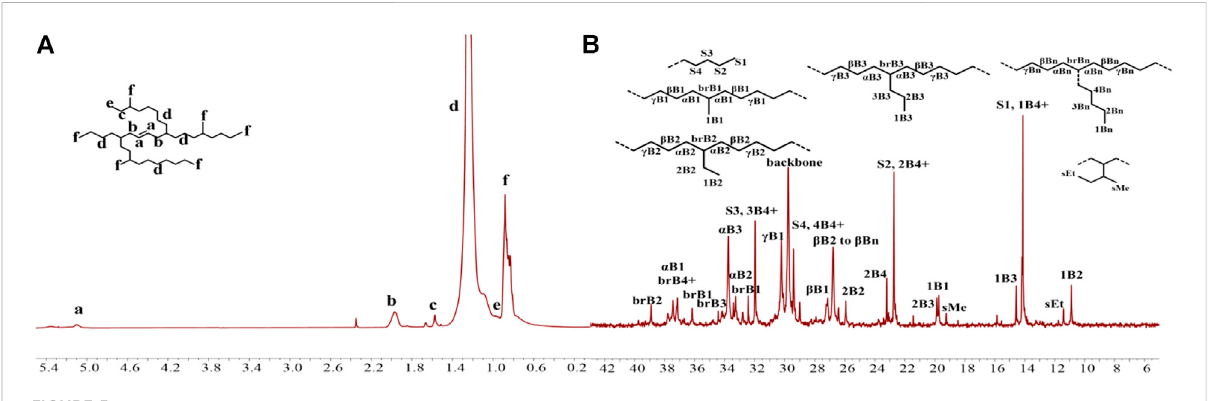
FIGURE 5 The 1 H (A) and 13 C (B) NMR spectral analyses of a hyperbranched ethylene oligomer obtained with Pd1 at 30 ° C. Assignments are numbered based on ref. Cotts et al., 2000; Randall, 1989; Galland et al., 1999. Supplementary Figures S1 − S4 are assigned to the chain ends. xBy delineates the branches, where x is the carbon, beginning with 1 at the methyl end and y is the branch length. brBy denotes the methine groups for branches with different lengths.